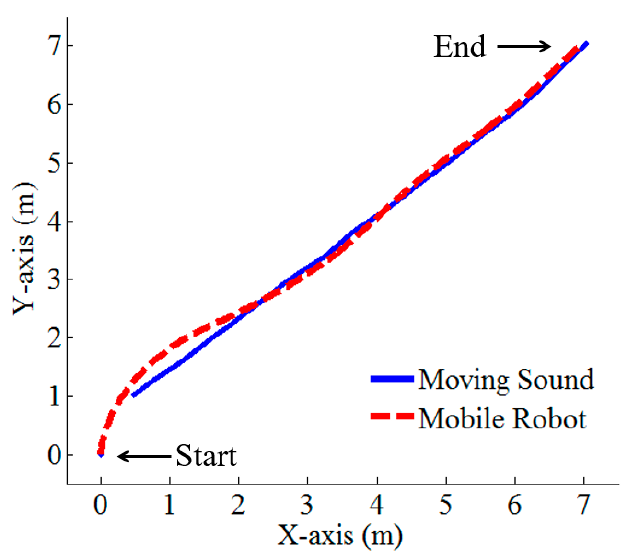
Figure 11. Experiments for checking the performance of sound tracking.